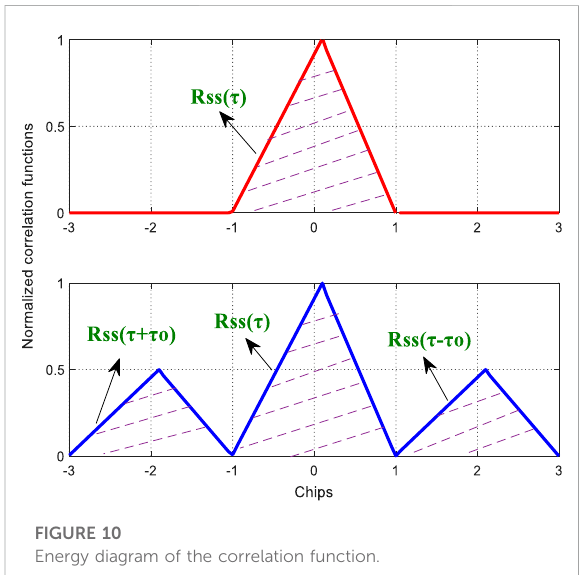
FIGURE 10 Energy diagram of the correlation function.